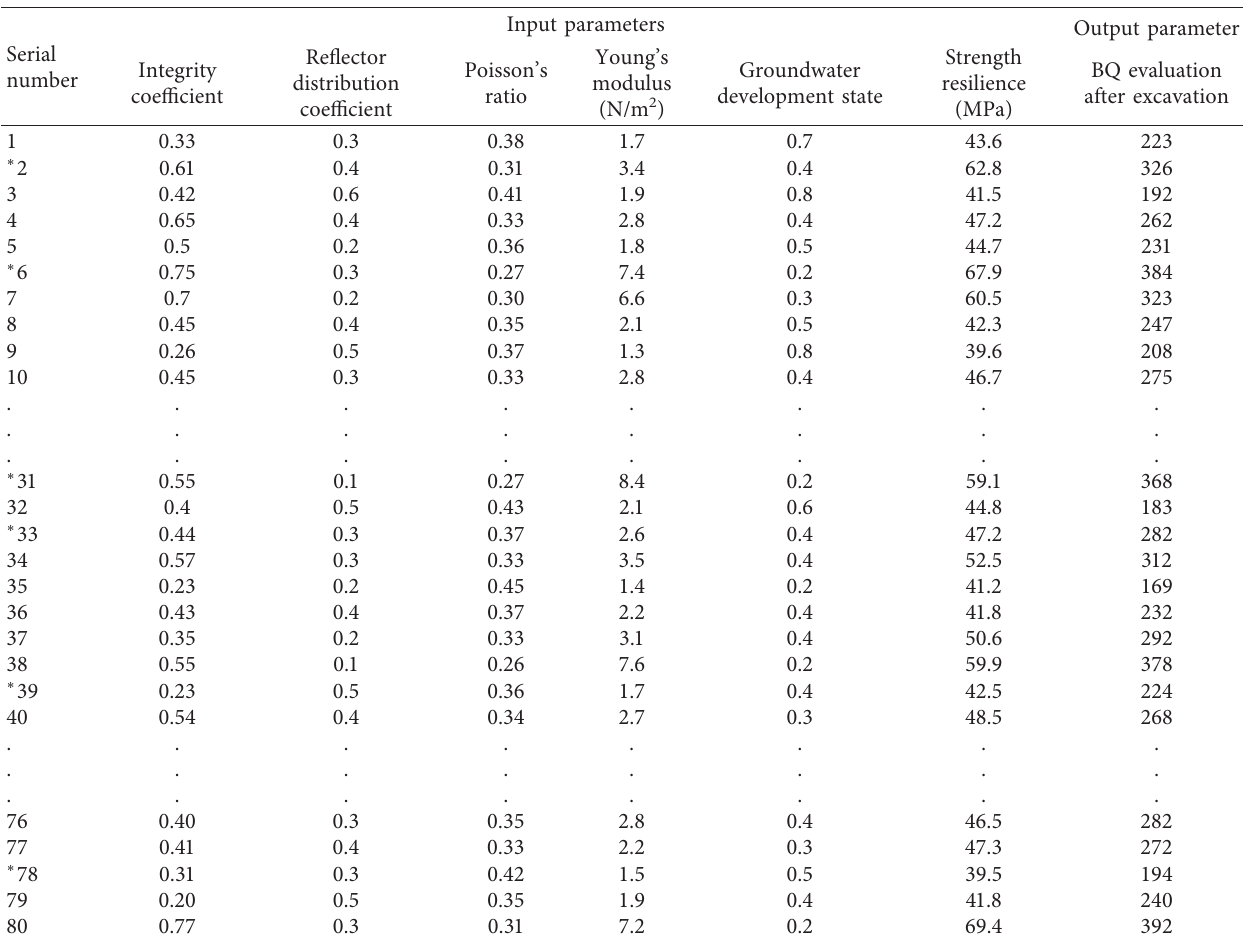
Table 4: Partial learning